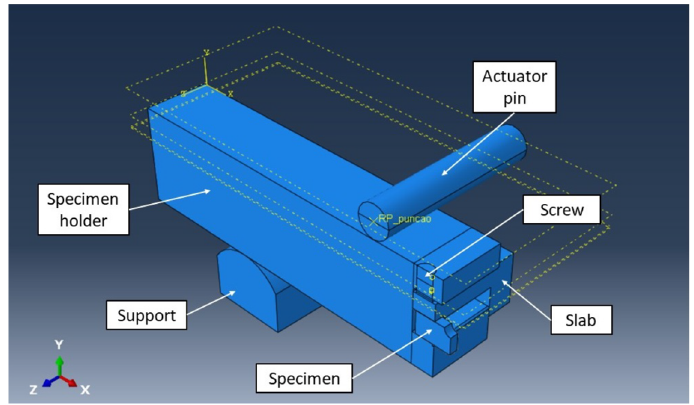
Figure 8. Numerical model main components [17].